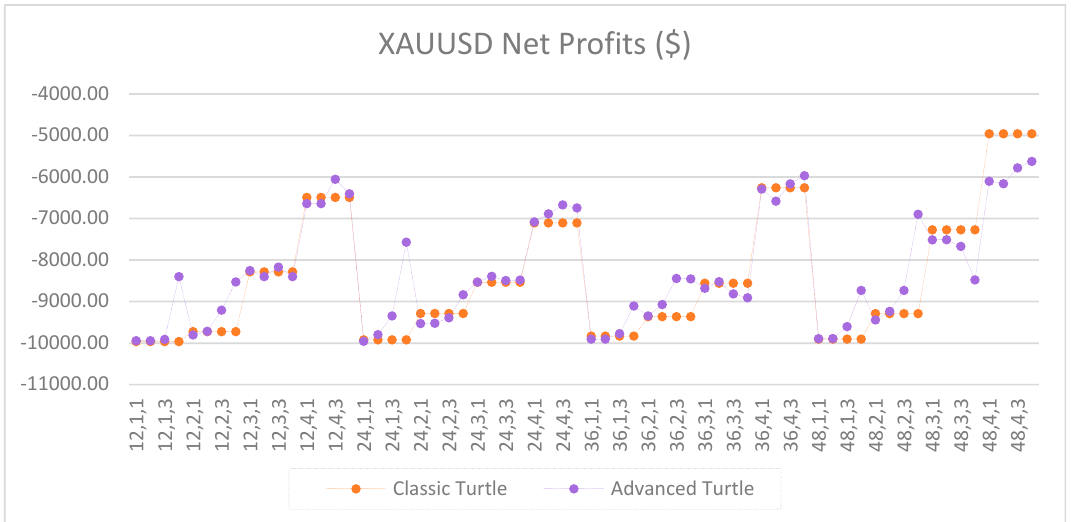
Figure A11. Net profits of XAUUSD between the classic and the advanced Turtle systems for every combination of N, X, Y for the fast parameters (20, 40).